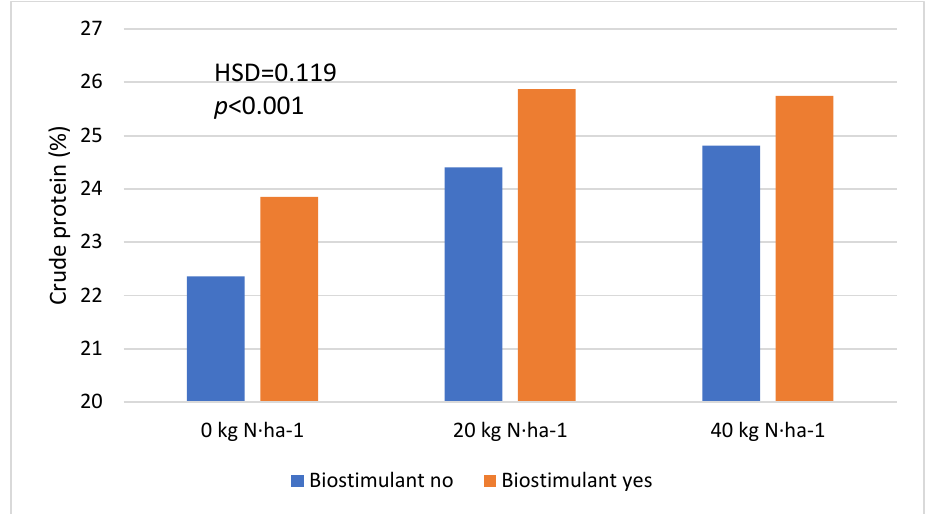
Figure 3. Crude protein content in pea seeds after application of nitrogen fertilization and biostimulant. HSD, honestly significant differences.